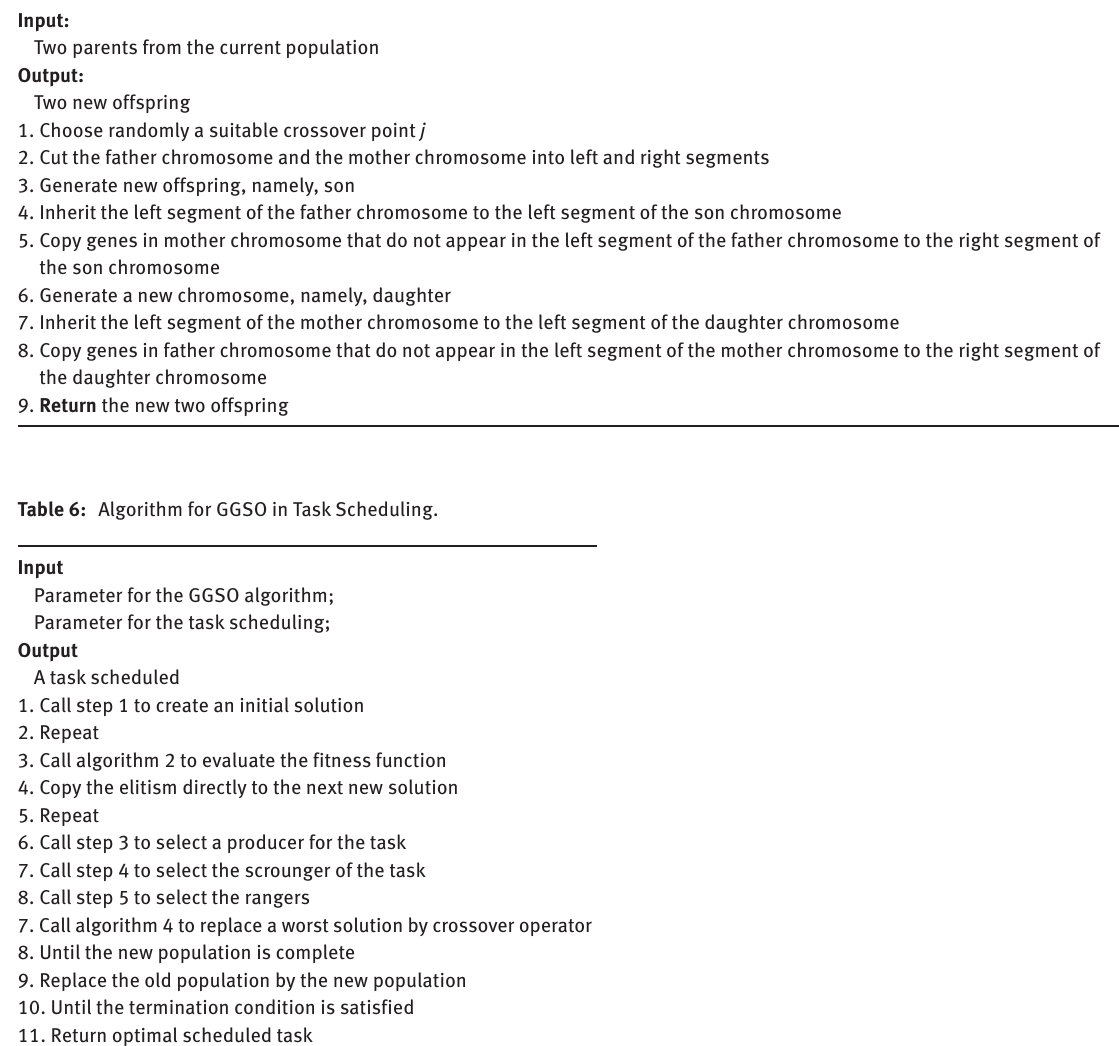
Table 5: Algorithm for Crossover Operator.